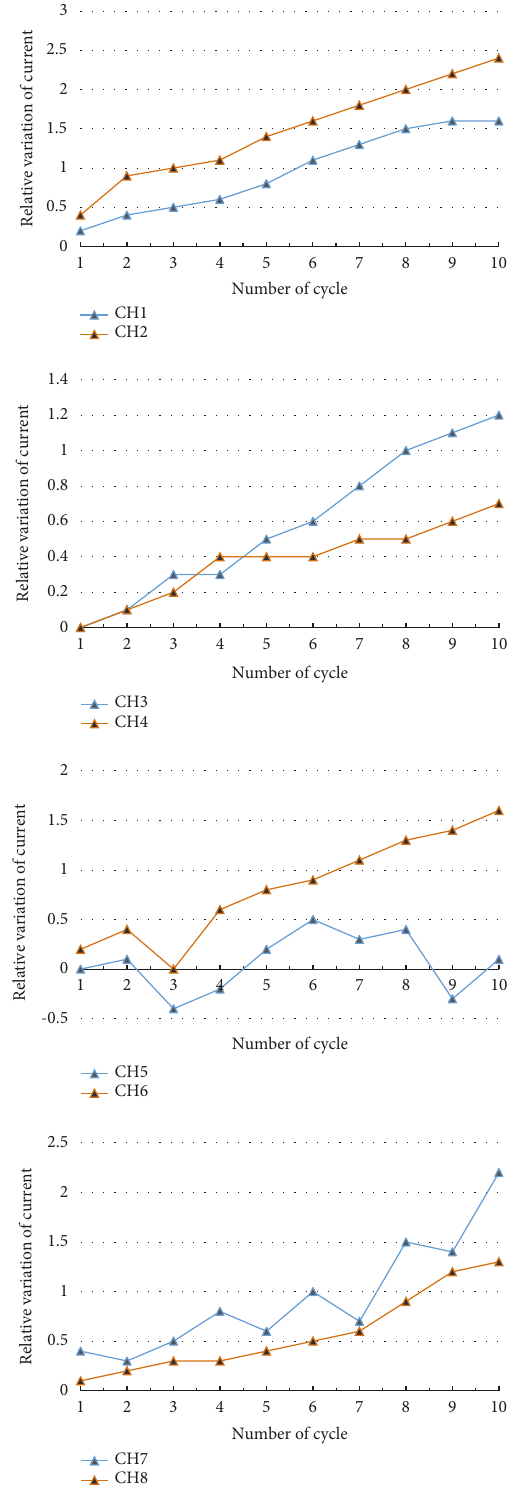
Figure 8: Current change diagram of the multichannel power